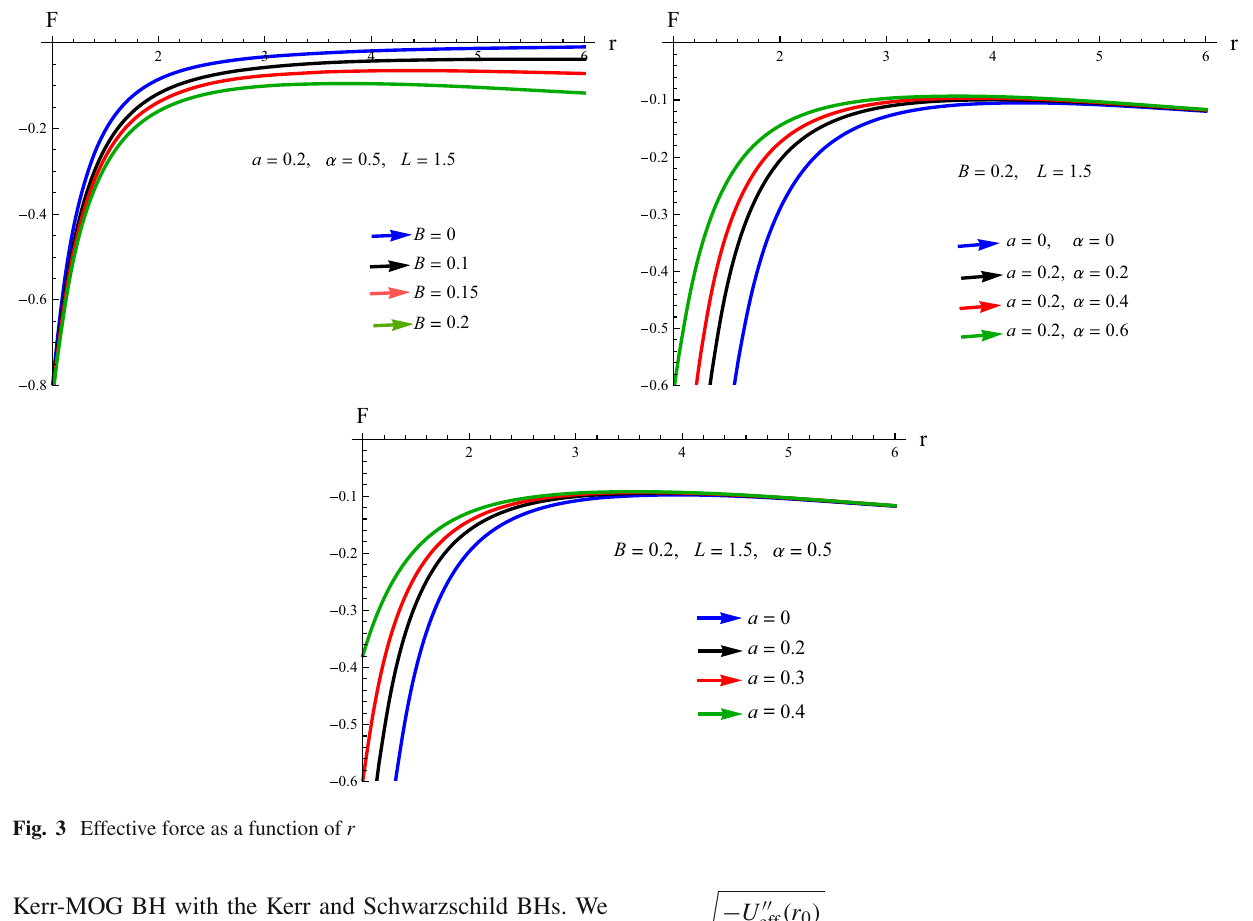
Kerr-MOG BH with the Kerr and Schwarzschild BHs. We see that the effective force on a particle for the Kerr-MOG BH attains higher values than the Kerr and Schwarzschild BHs and increases for increasing values of α . This means that repulsion in reaching the singularity for the Kerr-MOG BH is higher than that in Schwarzschild and Kerr BHs. The behavior of the effective force for different values of the spin parameter is represented in lower graph showing that the effective force acting on particles increases with the increase of the spin parameter and becomes almost con- stant as the particle moves away from the BH. It is also observed that the effective force on particles in the vicin- ity of Schwarzschild-MOG BH is small as compared to the Kerr-MOG